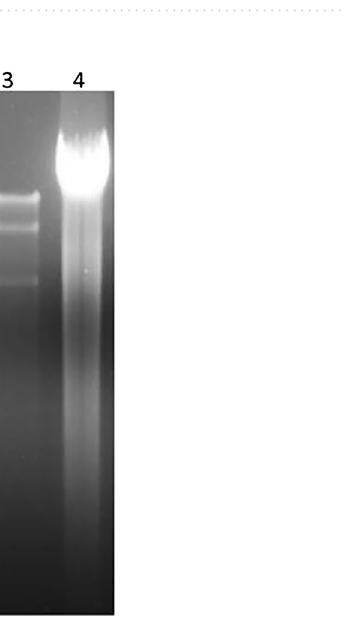
Figure 3. Electron microscopy of Abp95. ( A ) The morphology of Abp95 under TEM magnified by 0.5 million times ( A ) and 1 million times ( B ).